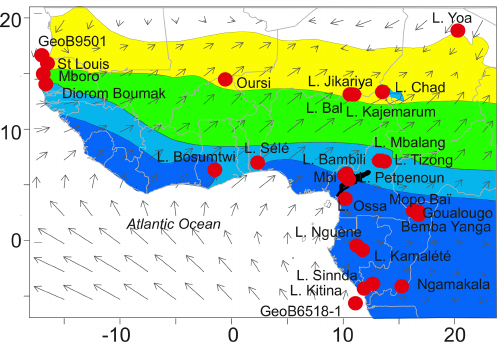
Figure 1. Map showing the location of paleo-records available in tropical West Africa documenting the last millennium (Table 1). Gray arrows indicate the strength and direction of the main 925hPa monsoonal winds during boreal summer, i.e., the WAM rainy sea- son (NCEP-DOE AMIP-II Reanalysis; Kanamitsu et al., 2002). In color, vegetation units from White (1983): dark blue, Guineo- Congolian rainforest; light blue, Sudano-Guinean woodland and wooded grassland (here referred to as savannah (vegetation) zone); green, Sudanese woodland and wooded grassland; yellow, Sahelian grassland and wooded grassland; black, Afromontane